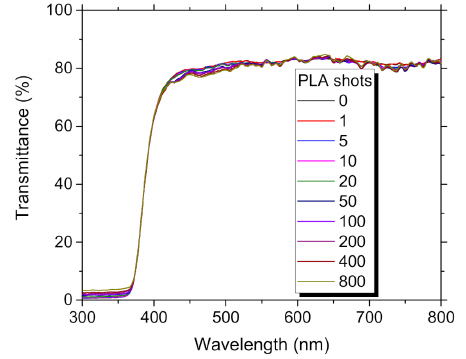
Figure 3. Transmittance spectra ZnO:Eu thin film, dependence on the number of PLA shots.